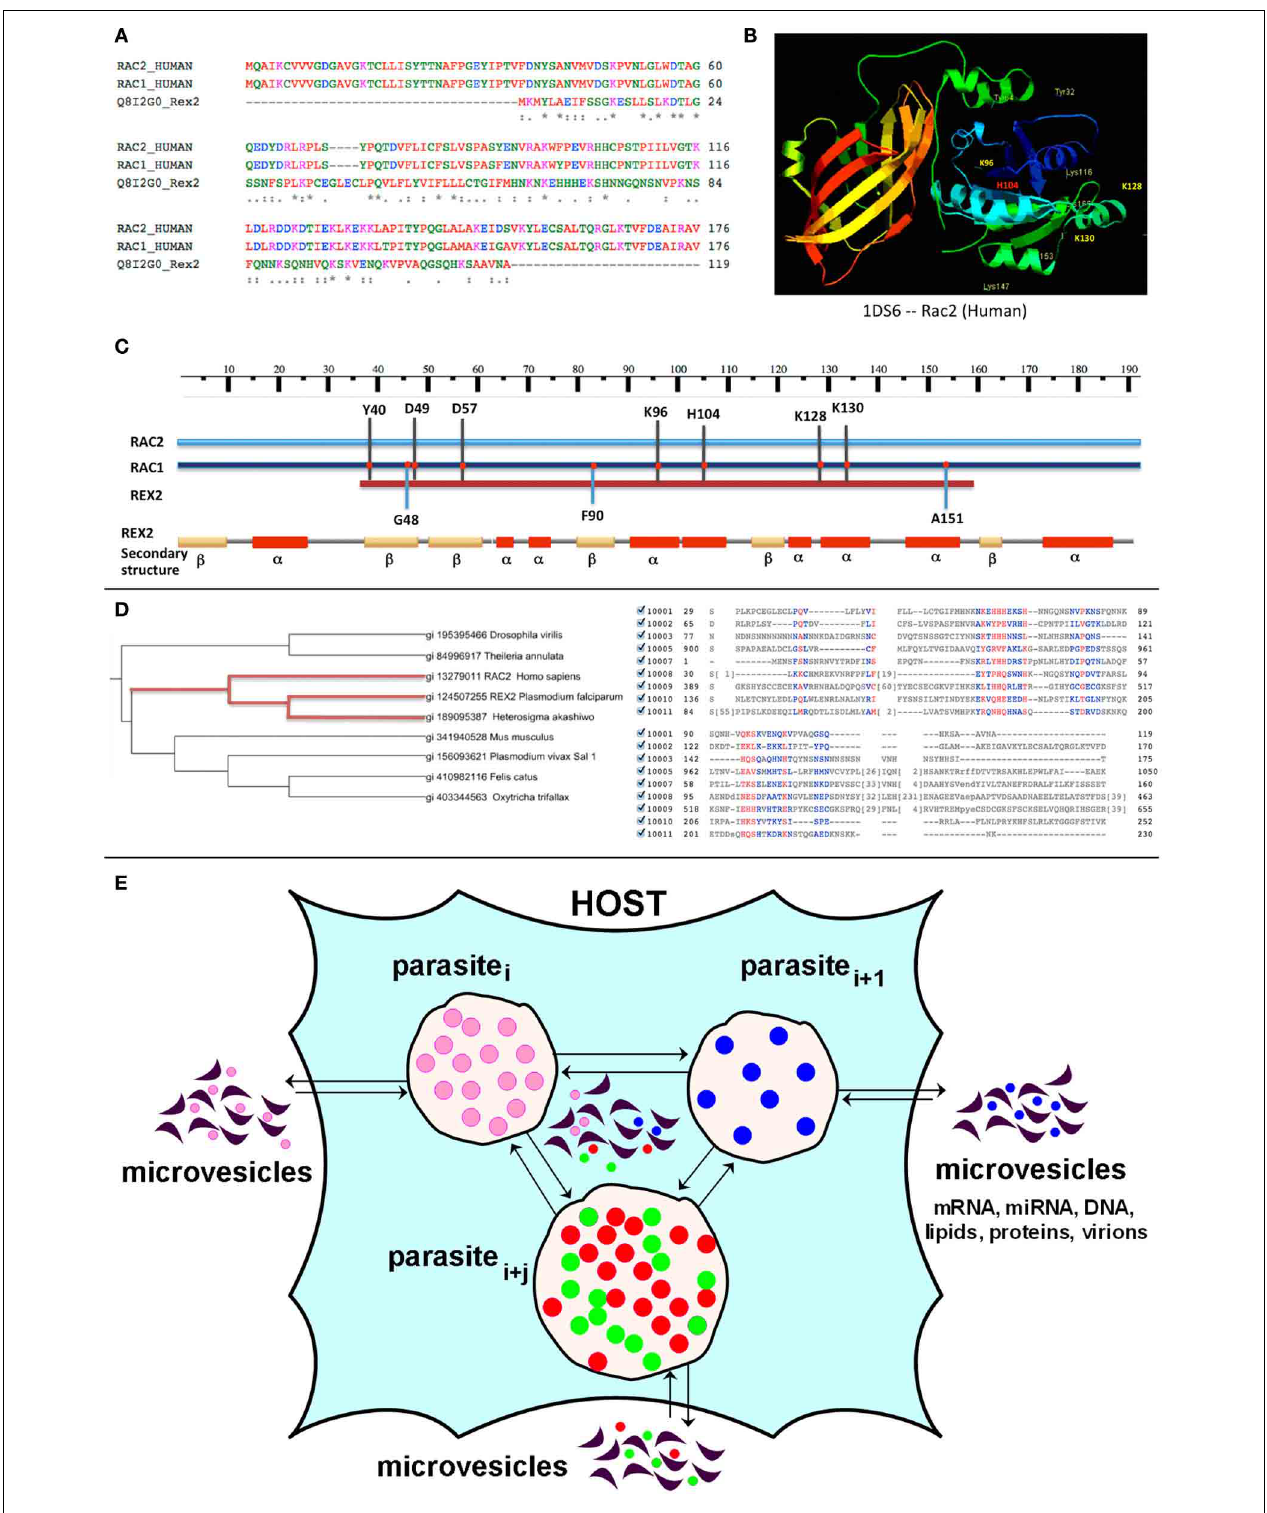
FIGURE 1 | Alignment and PSI-Blast analysis of Rex2 P. falciparum protein. (A) ClustalW sequence alignment of Rex2 P. falciparum protein (NCBI accession XP_001352224; Uniprot ID Q8I2GO_PLAF7) with Human Rac1 protein (NCBI accession AAH04247; Uniprot ID RAC1_HUMAN) and Ras-related C3 botulinum toxin substrate 2 RAC2_HUMAN. As follows from